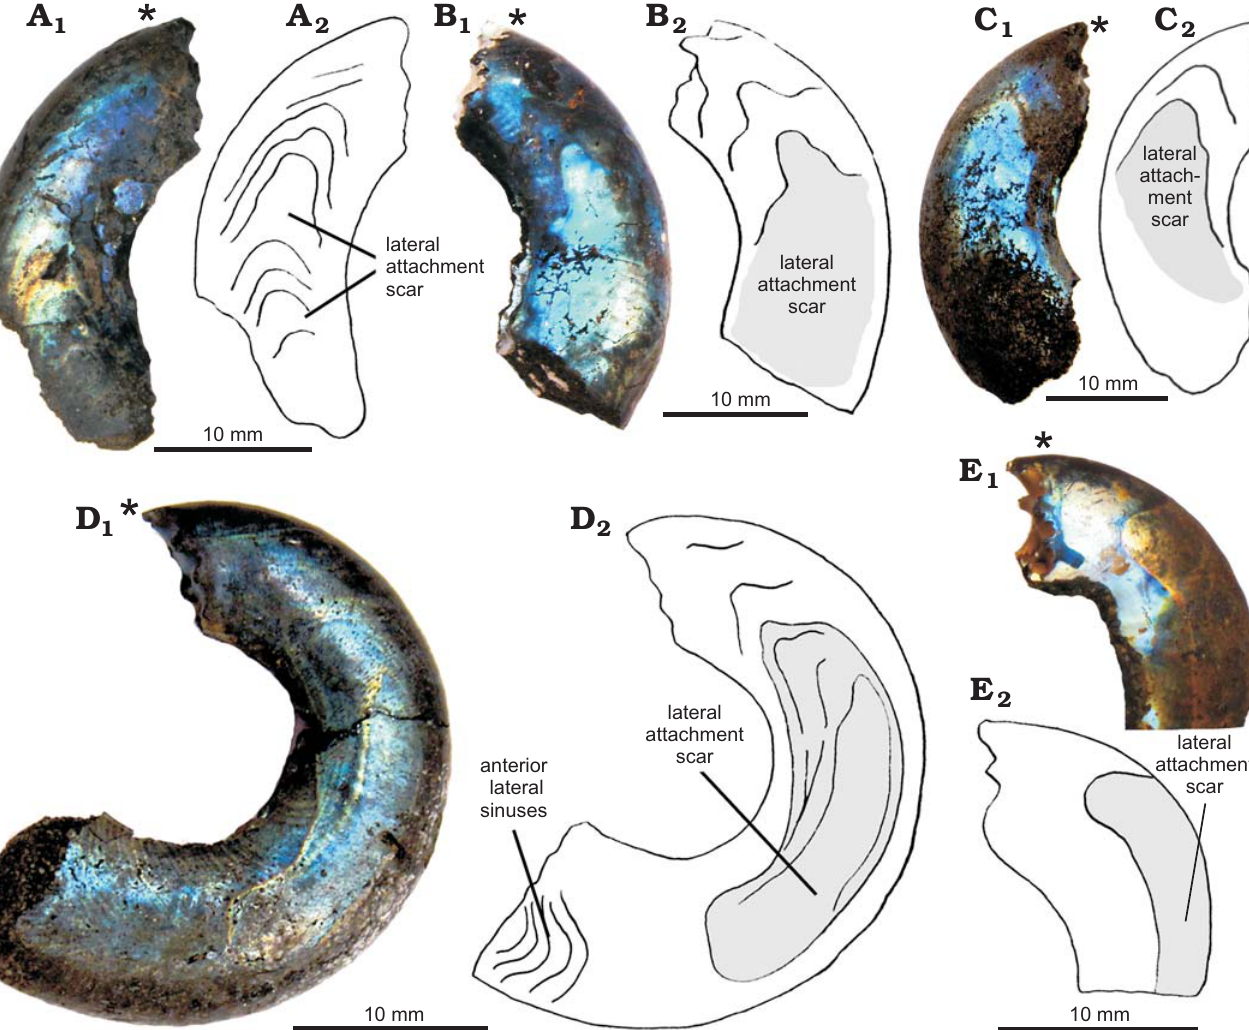
Fig. 9. Posterior borders of the lateral attachment scars on the Kachpurites fulgens (Trautschold, 1861) ( A – D ) and Garniericeras catenulatum (Fischer, 1830) ( E ) shells from Late Volgian ( Kachpurites fulgens and Craspedites subditus zones, respectively), Moscow region, Eganovo locality (A–D), Kuntsevo locality (E). A . MSU 113/29, apical part of body chamber with a series of posterior borders of scars very similar to the lateral sinuses. B . MSU 113/32, sinus-like lines on the posterior part of the shell, scars near the last septum. C . MSU 113/33, sinus-like lines on the posterior part of the shell, scars near the last septum. D . MSU 113/8, part of body chamber with scars and lateral sinuses. Scar has a series of clearly visible sinus-like posterior borders. The specimen is preserved without aperture. E . MSU 113/43, apical part of the body chamber, posterior border of a scar is visible on one side of this specimen at a distance from the last septum. Asterisks mark the base of the body chamber. Photographs (A